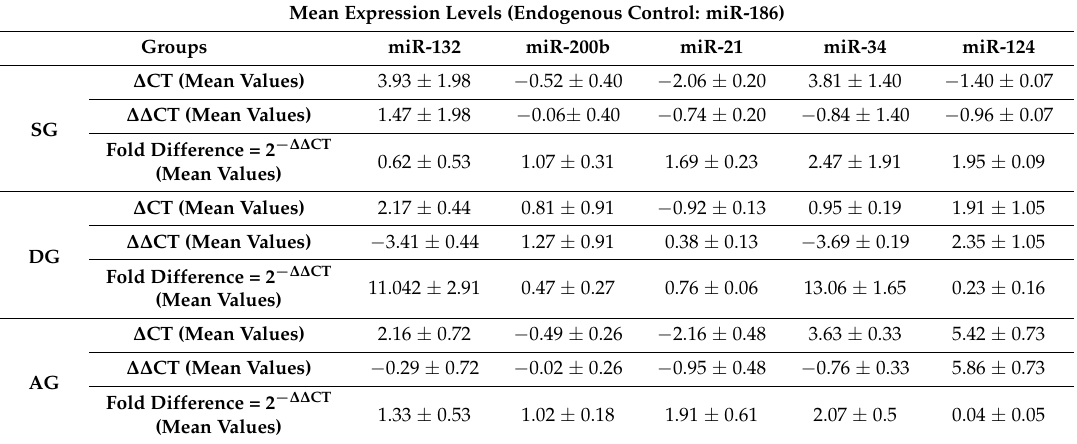
Table 1. Expression levels of microRNAs (miRNAs) analyzed in each group, reporting the mean values of ∆ CT (threshold cycle) and ∆∆ CT. SG, stroke group; DG, drug group; AG, aged group. Mean Expression Levels (Endogenous Control: miR-186)